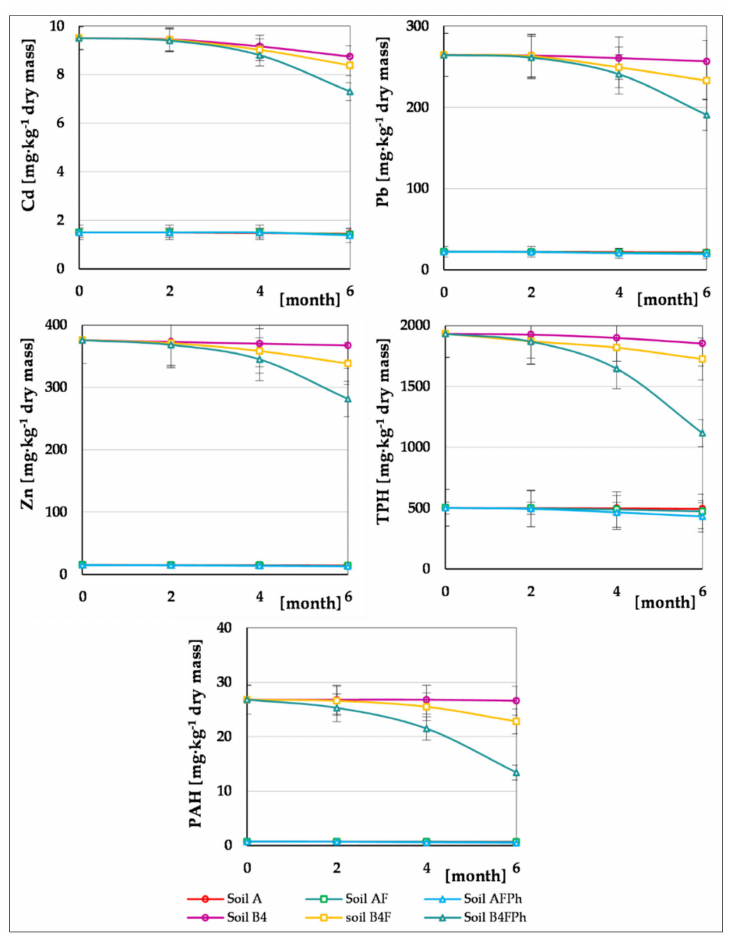
Figure 4. Comparison of reduction in the concentrations of Zn, Pb, Cd, petroleum hydrocarbons (TPH) and polycyclic aromatic hydrocarbons (PAH) during phytoremediation of soils: raw (A, B4), after fertilization (AF, B4F) and after phytoremediation carried out with M. officinalis (AFPh, BFPh) (repetition number n = 5–6, p < 0.05).